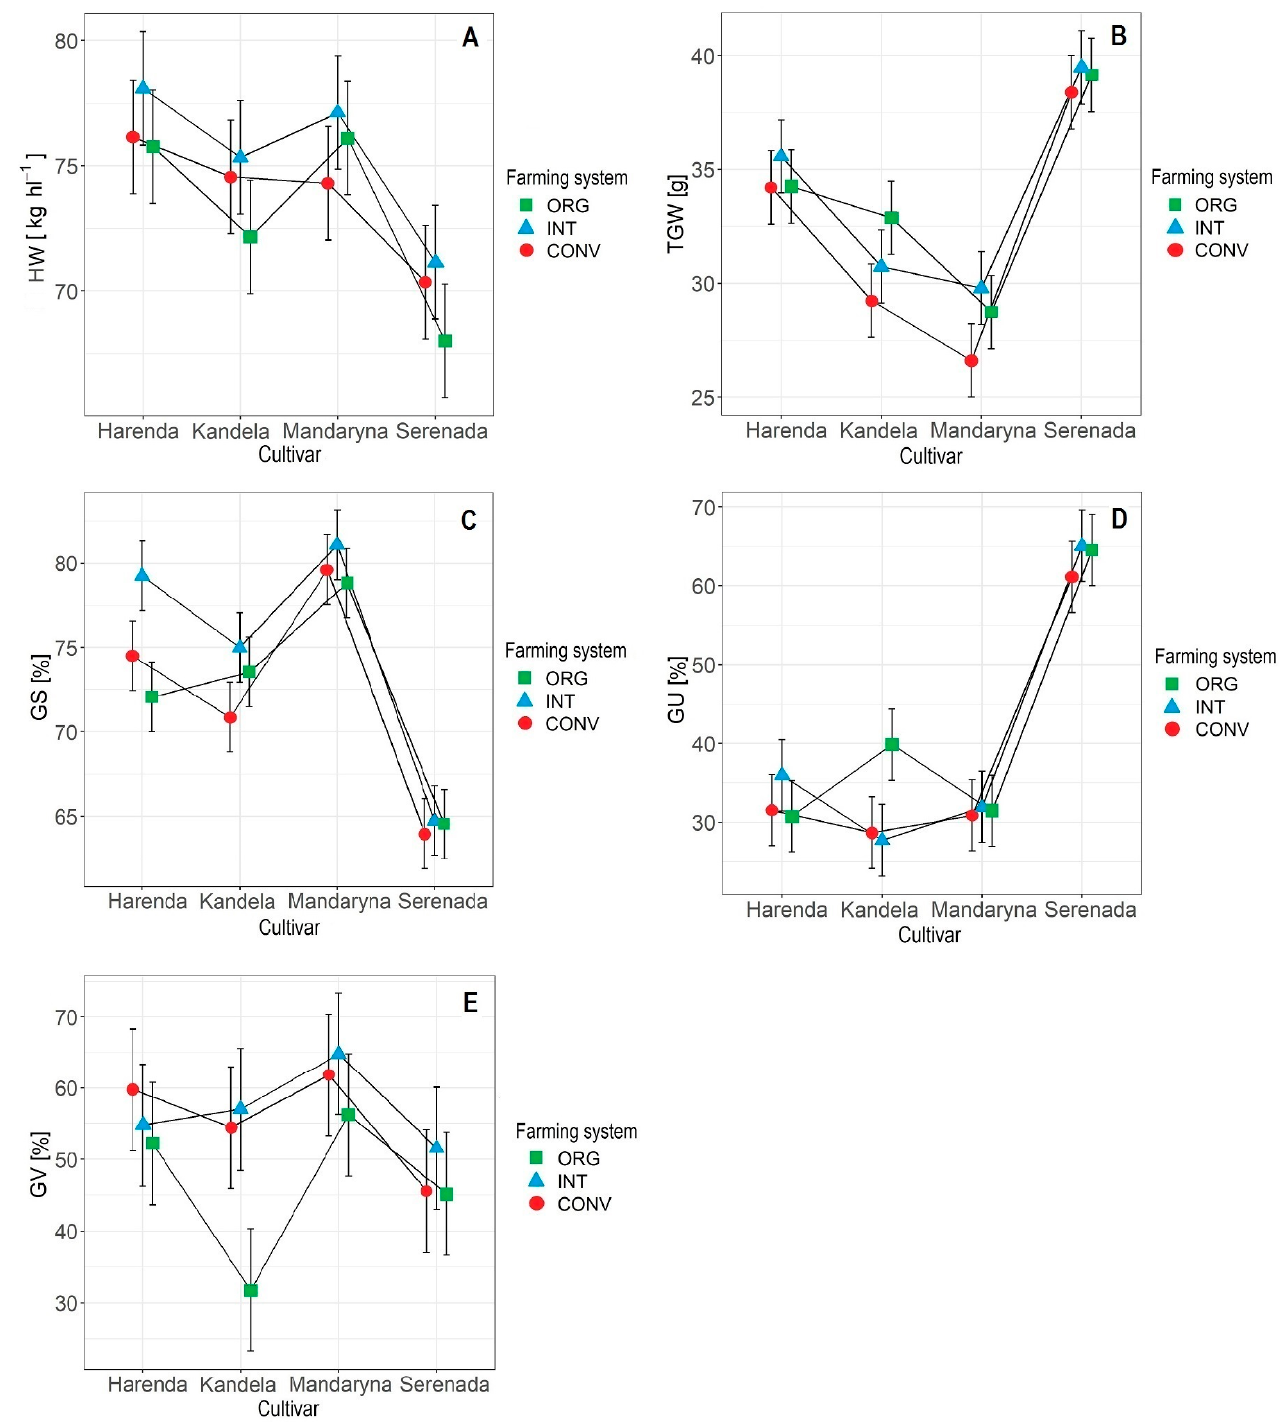
Figure 3. The interaction effects of cultivar and farming system on the physical properties of wheat grain. Abbreviations: ( A ) HW—hectolitre weight, ( B ) TGW—1000 grain weight, ( C ) GS—grain selectivity, ( D ) GU—grain uniformity, ( E ) GV—grain vitreousness, ORG—organic, INT—integrated, and CONV—conventional.